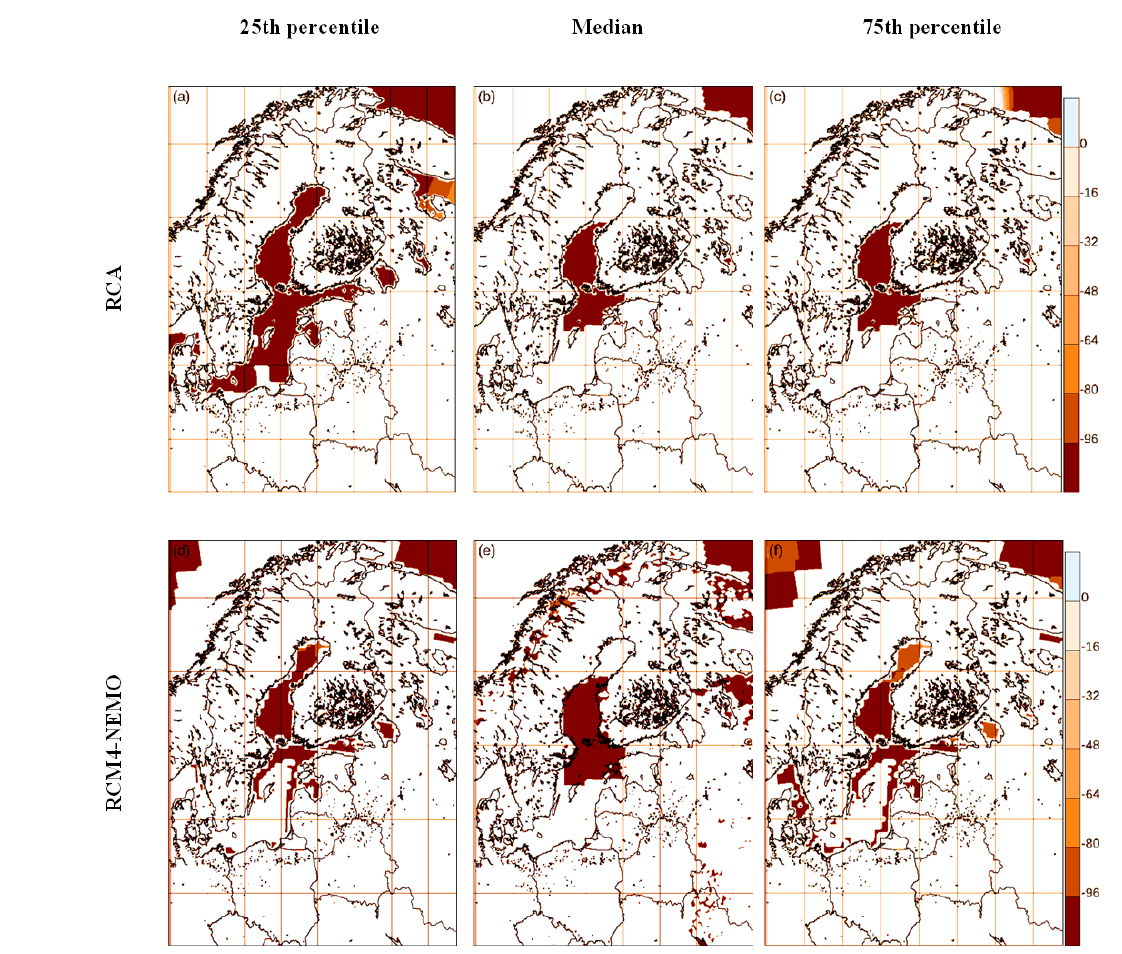
Figure 9. (a–c) Average winter sea-ice cover relative change between 1981–2010 and 2071–2100 for the simulations from EURO-CORDEX according to the RCP8.5 scenario driven by the GCMs where RCA4-NEMO simulations exist. These values have been interpolated before the RCM simulations from the driving coupled GCM; note that several simulations have sea ice in the Baltic Sea in the present-day period but not in the Bothnian Bay. For comparison, in panels (d–f) , we also show the corresponding fields from the corresponding five coupled RCA4-NEMO simulations where sea-ice cover is calculated inside the regional model. (a, d) Lowest quartile; (b, e) median value; (c, f) higher quartile. For the medians, only points where 75% of models agree on the sign are